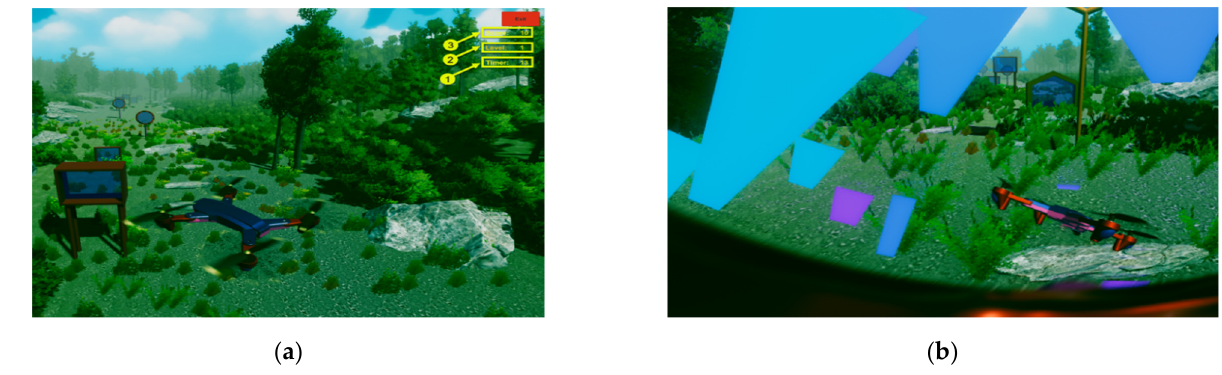
Figure 17. ( a ) Drone control for obstacles crossing. ( b ) Passing the drone through obstacles.